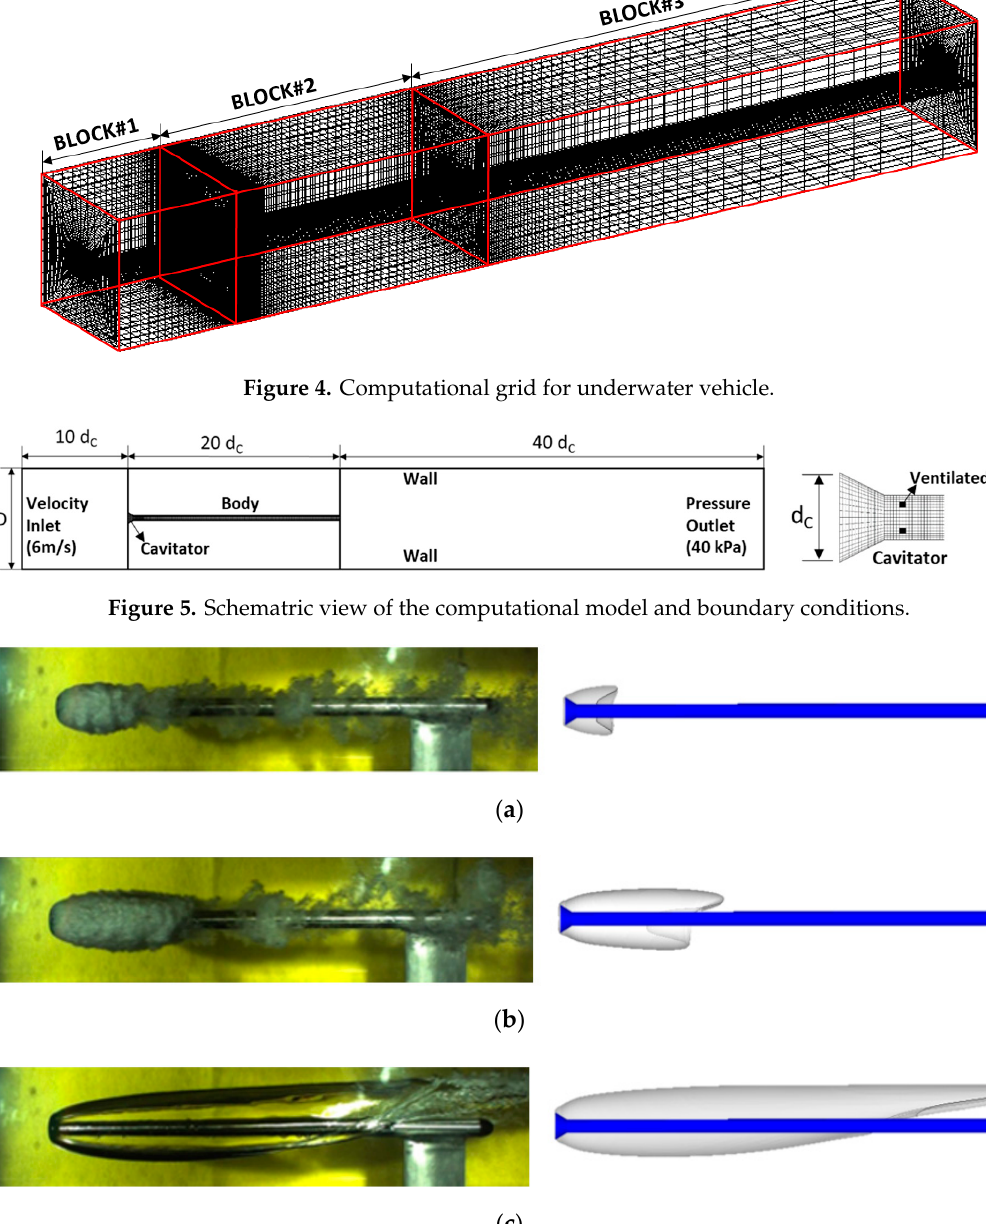
Figure 6. Cavitation formation at various ventilated rate coefficients: ( a ) Fn = 10.8, Cq = 0.10, ( b ) Fn = 10.8, Cq = 0.15, and ( c ) Fn = 10.8, Cq = 0.20. (Abbreviations: gas flux coefficient (Cq), flow field characteristic (Fn))